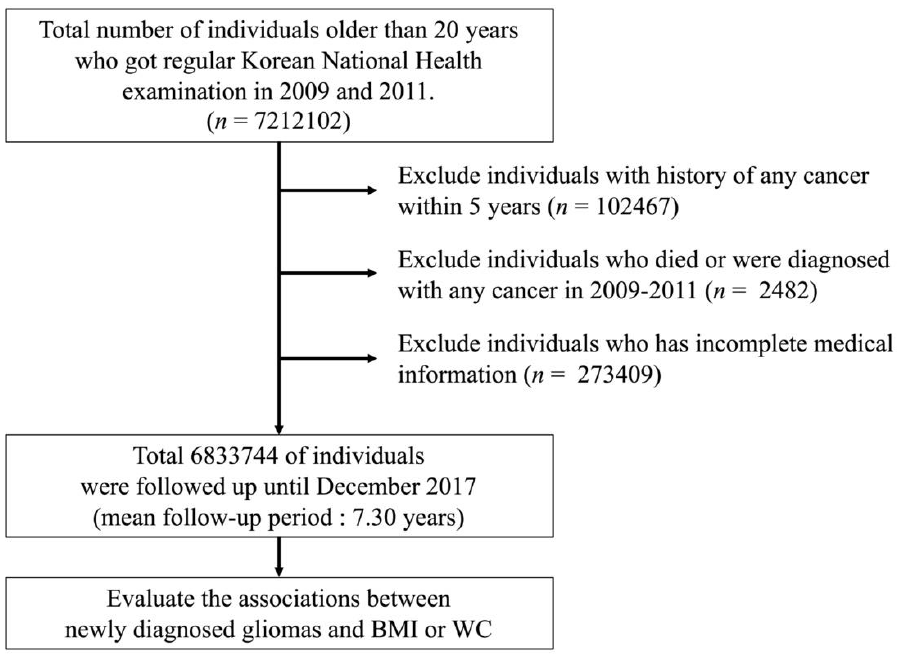
Figure 2. Flow of enrollment of study participants.